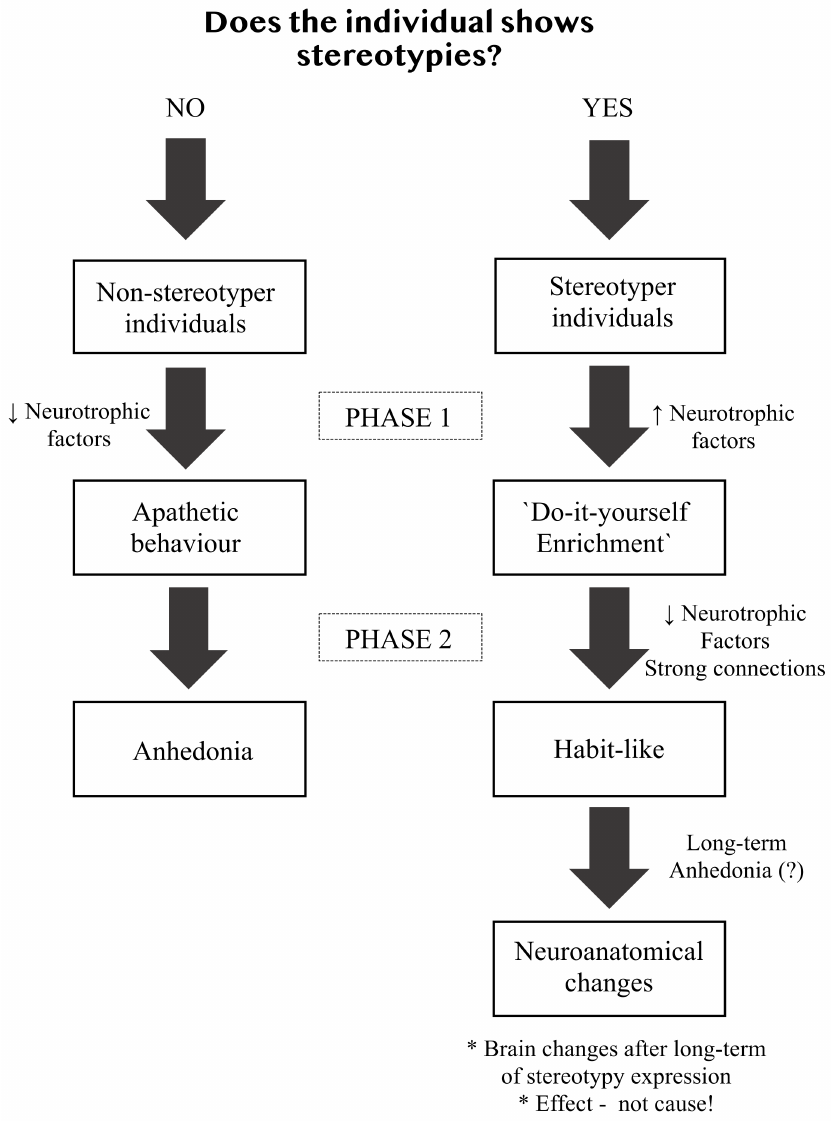
Figure 1. The consequences of negative environments over time on the stereotypies